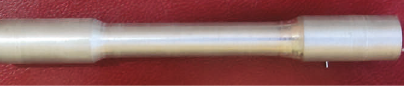
Figure 3: Tensile test